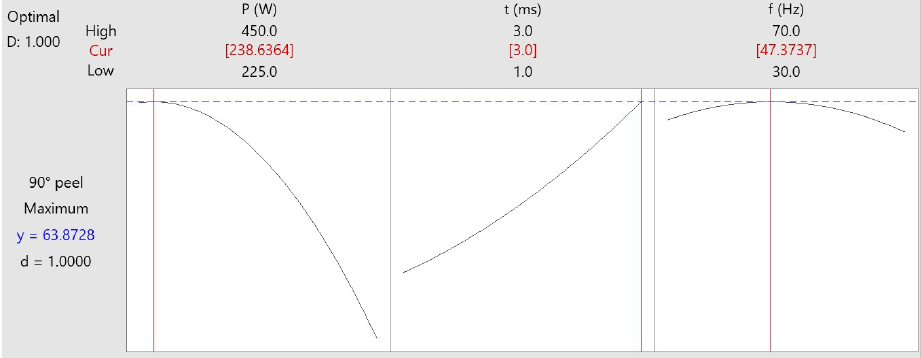
Figure 9. Optimization results for average maximum peak load (PL).